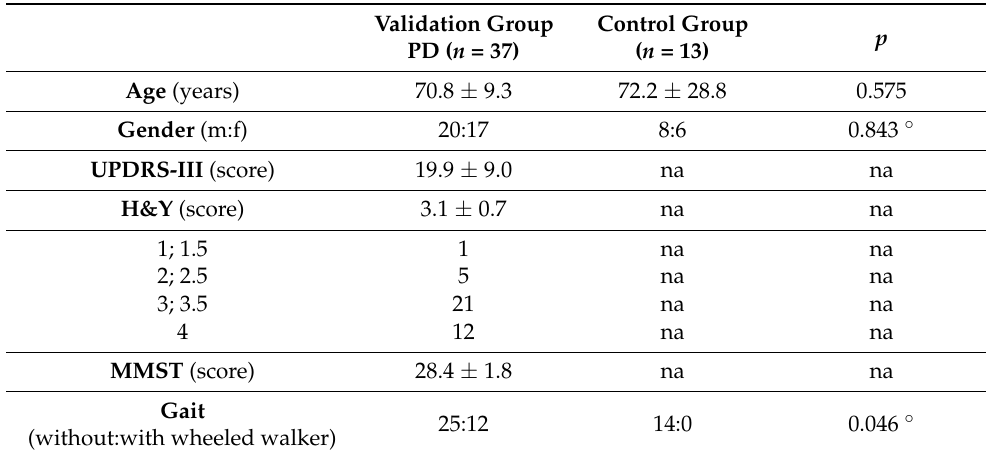
Table 1. Characteristics of PD patients and control group. H&Y: Hoehn and Yahr disease